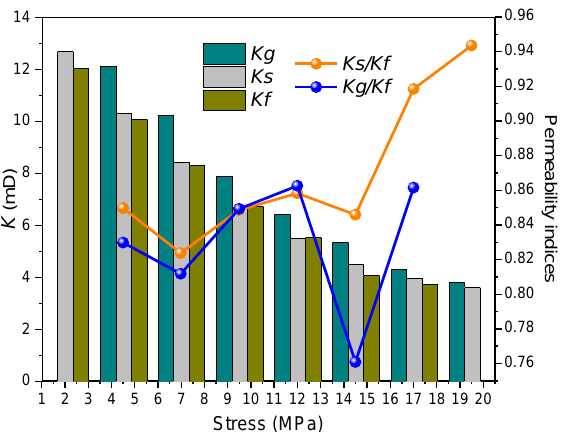
Figure 13. Changes in permeability of raw coal and its recovery rate at different stress levels under stress path 1.